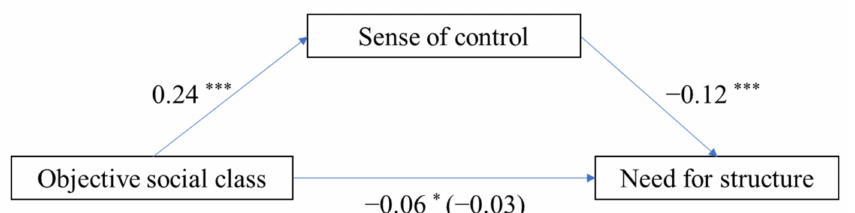
Figure 2. Model of the mediating role of perceived control in the association between objective social class and need for structure; * p < 0.05, *** p < 0.001.